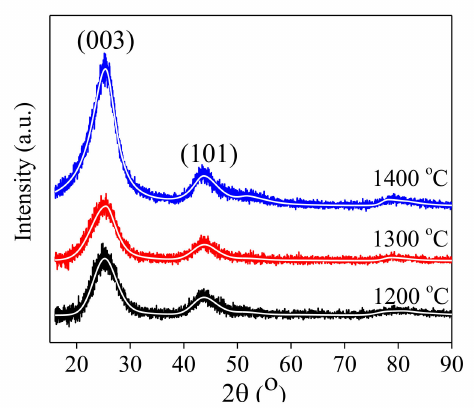
Figure 3. X-rays difraction difractograms of the samples carbonized at 1200 ◦ C (C-5), 1300 ◦ C (C-10), and 1400 ◦ C (C-15). The continuous lines are fits to